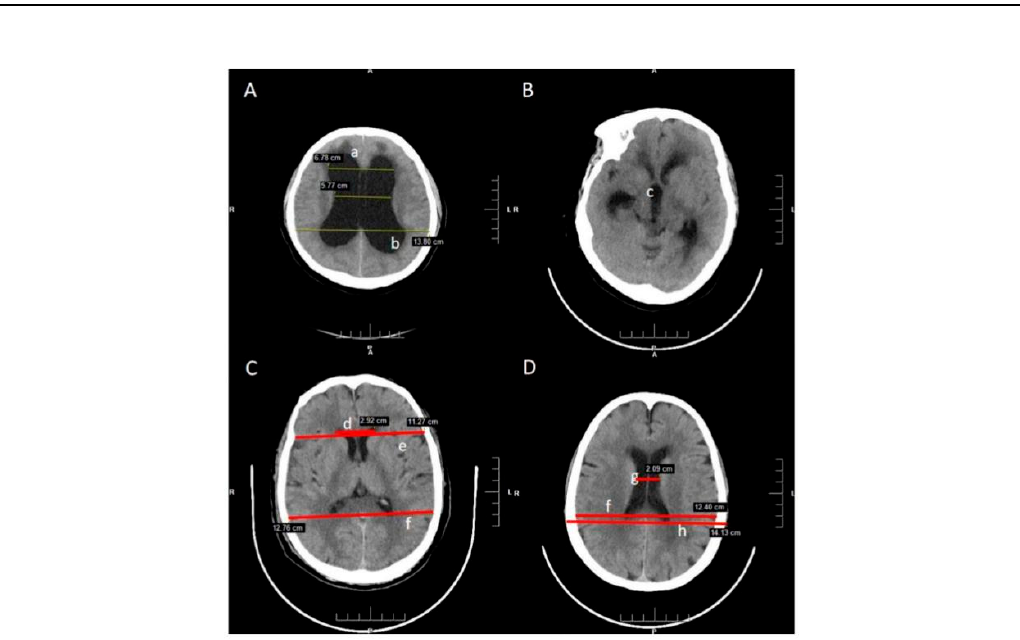
Figure 1. Radiological features and morphometric parameters in CT image. A.The layer of enlargement ventricle; B.The layer of third ventricle; C.The layer of maximum width of the internal diame ‐ ter D. The layer of maximum transverse diameter of the skull and the narrowest width between the lateral walls(not necessarily on same level). a. Dilated temporal horns; b. Rounded posterior horns; c. Dilated third ventricle; d. Frontal Horns’ Length; e, Inner diameter of the skull in the same line as FHL; f. Maximum width of the internal diameter of the skull; g. The narrowest width between the lateral walls; h. Maximum transverse diameter of the skull.